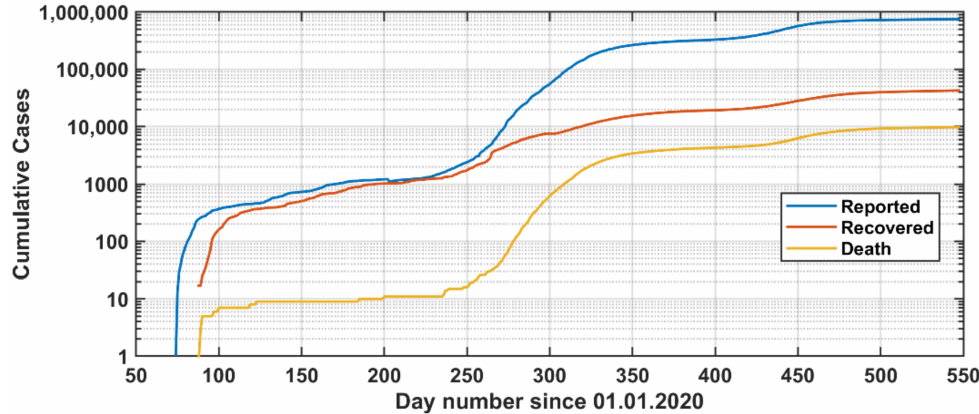
Figure 2. Cumulative reported cases of positive qPCR tests, recovered, and death since the first case was reported in Jordan (14 March